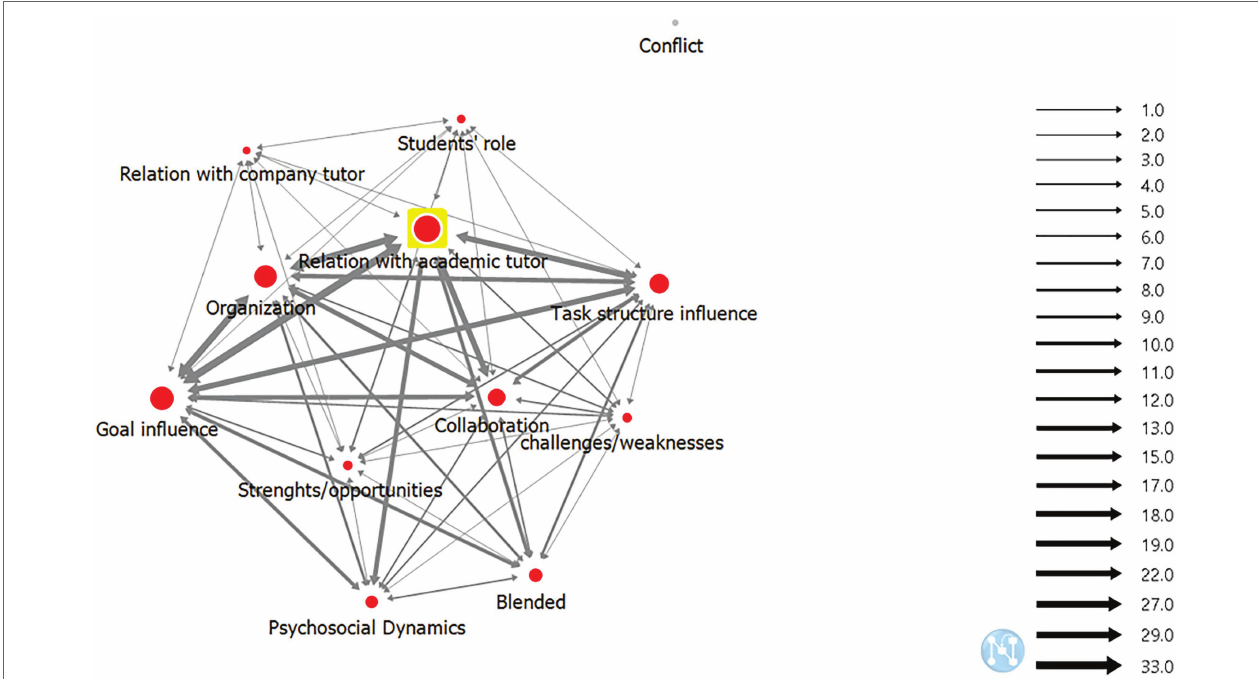
FIGURE 2 | Neighbour analysis of co-occurrences in the chats with only academic tutors (L1-G1).